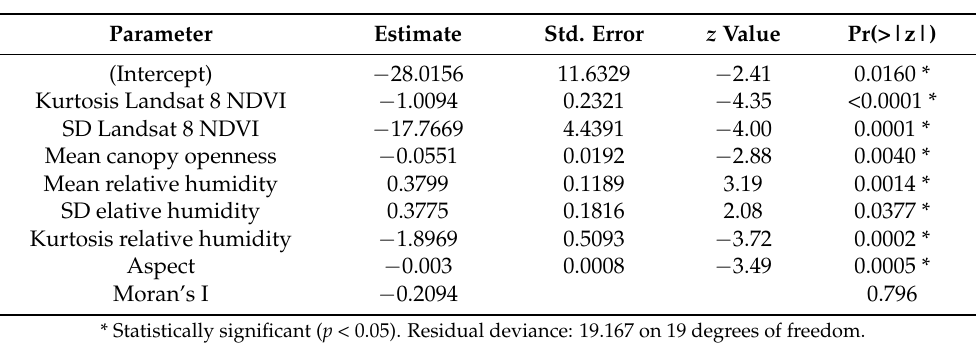
Table 2. Parameter estimates for the best Poisson model explaining Tripteroides bambusa adult abundance at Mt. Konpira, Nagasaki, Japan.